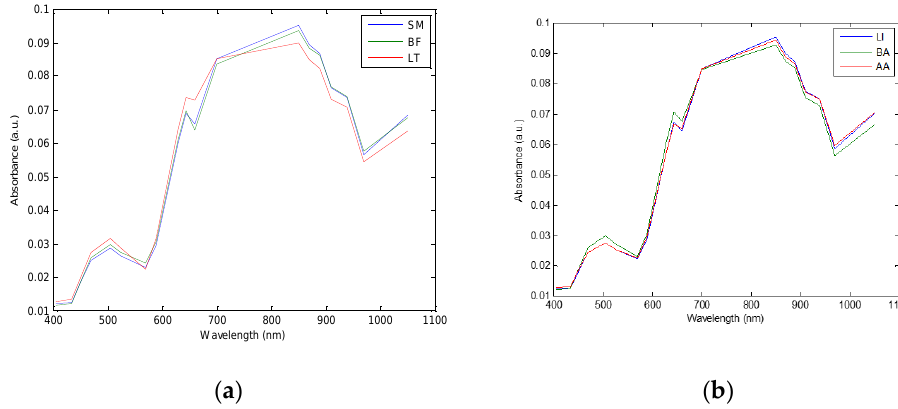
Figure 3. ( a ) Mean spectra of the three muscles; Biceps femoris (BF), Longissimus thoracis (LT), and Semimembranosus (SM) of the Blonde d’Aquitaine breed and ( b ) mean spectra of the three breeds; Aberdeen Angus (AA), Blonde d’Aquitaine (BA), and Limousine (LI) considering all three muscles.